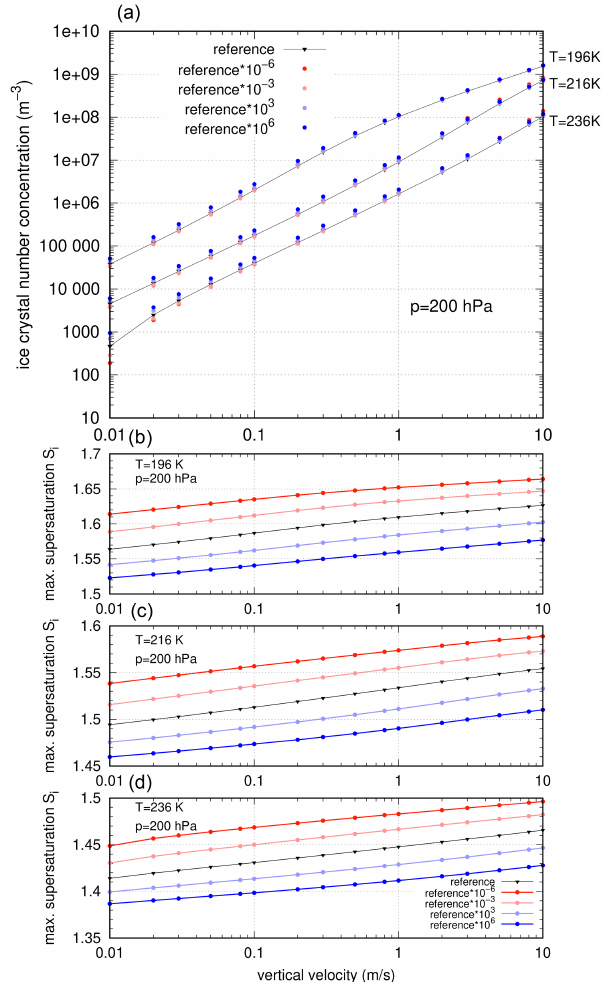
and maximum supersaturation ( b–d , temperature T = 196, 216, and 236K) for absolute changes in the nucleation rate by a factor 10 (cid:49)b , with (cid:49)b ∈ {− 6 , − 3 , 3 , 6 }